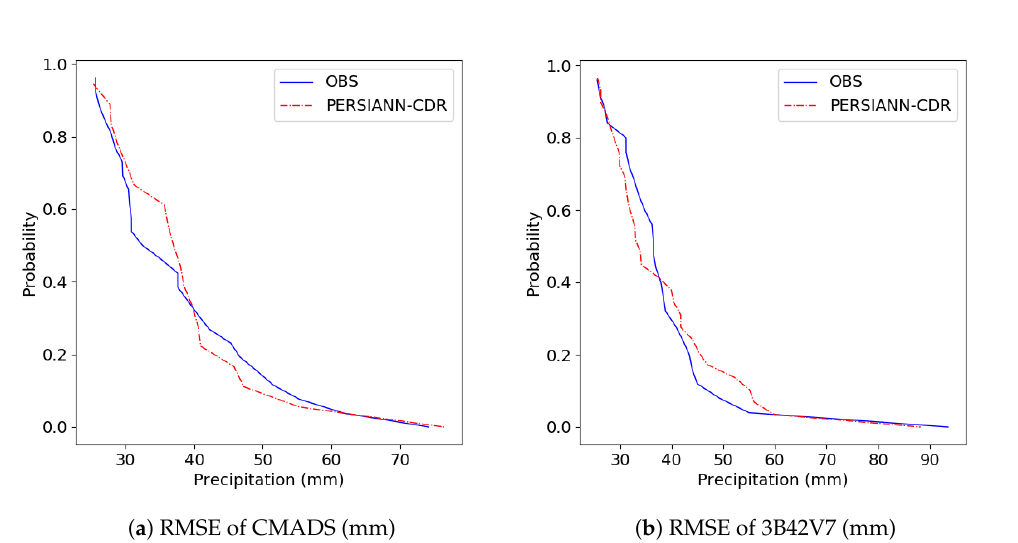
Figure 9. Cumulative distribution curves of gauge precipitation and PERSIANN-CDR